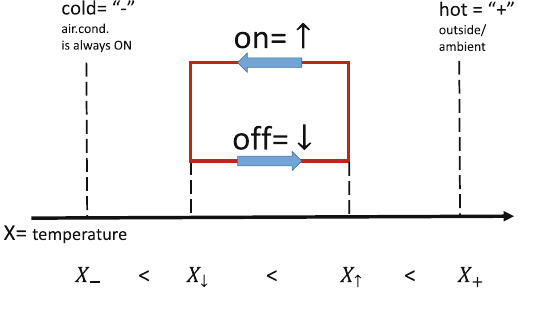
Figure 1. Basic TCL (cooling)